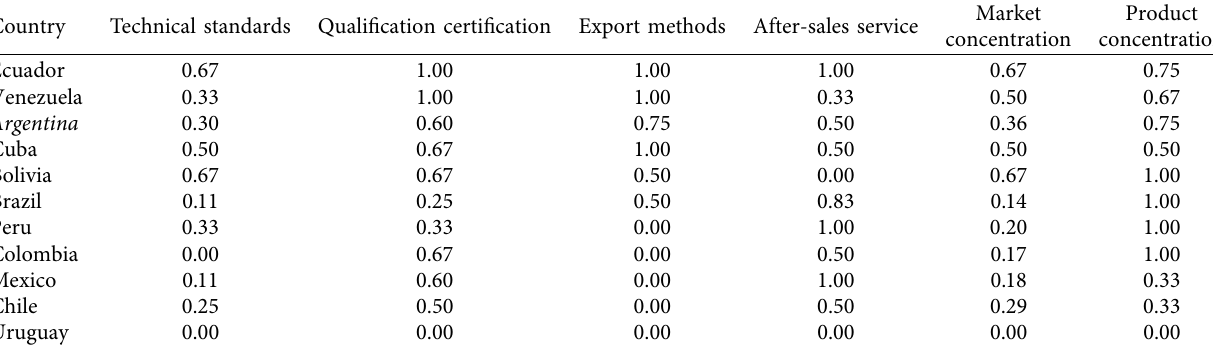
Figure 10: Matching effect picture of Chinese power companies in Latin America. Table 10: Matching indicators value of Chinese power companies in Latin America.